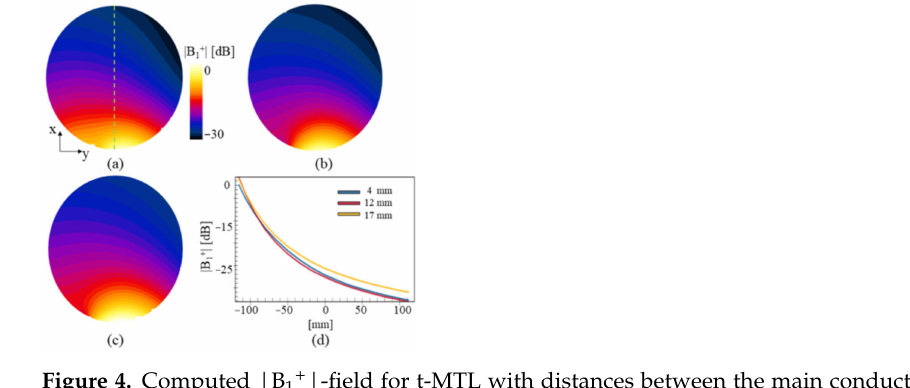
Figure 4. Computed |B 1+ |-field for t-MTL with distances between the main conductor line and adjacent coupled lines of ( a ) 4, ( b ) 12, and ( c ) 17 mm. The field profile for each of the computed |B 1 + |-fields is depicted in ( d